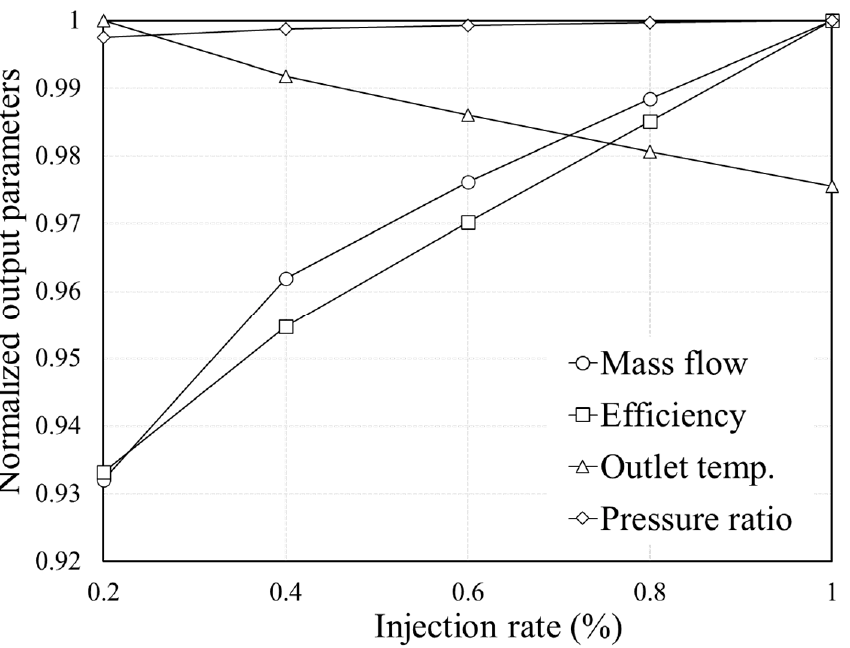
Figure 20. Effect of the different mass flow rates on the centrifugal compressor performance .